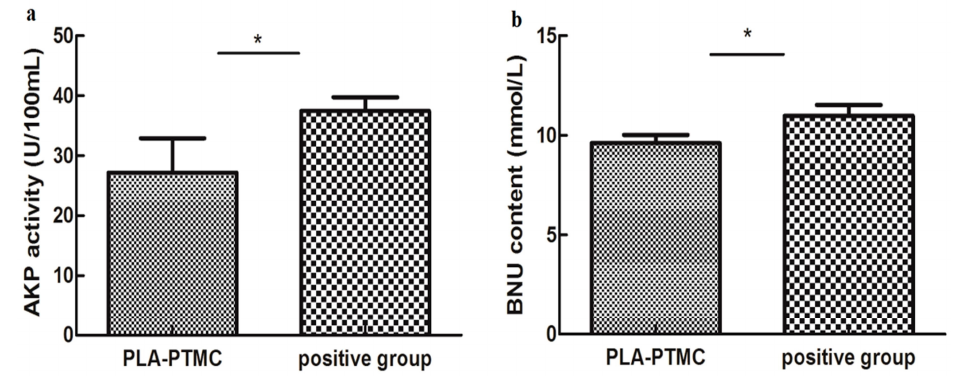
Figure 10. The AKP (alkaline phosphatase) activity ( a ) and the blood urea nitrogen (BUN) content ( b ) of PLA-PTMC and the positive group. Values are the means ± S.E.M. ( n = 5). * p < 0.05 compared with the control group; * p < 0.01 compared with the control group; * p > 0.05 was considered not to be statistically different. These indicators were detected using different kits that were obtained from the Nanjing Jiancheng biological technology limited company (Nanjing, China).